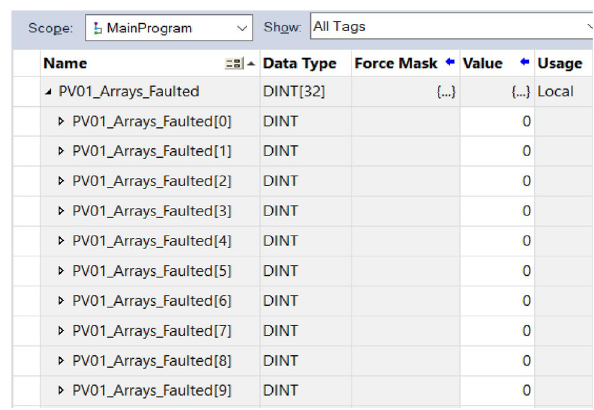
Fig. 10 Suppressed or Deenergized faults means values are set to zero